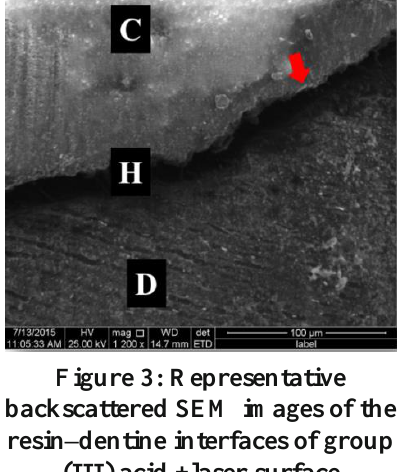
Figure 3: Representative backscattered SEM images of the resin–dentine interfaces of group (III) acid +laser surface conditioning. (C composite, H hybrid layer, D dentine, red arrow refer to